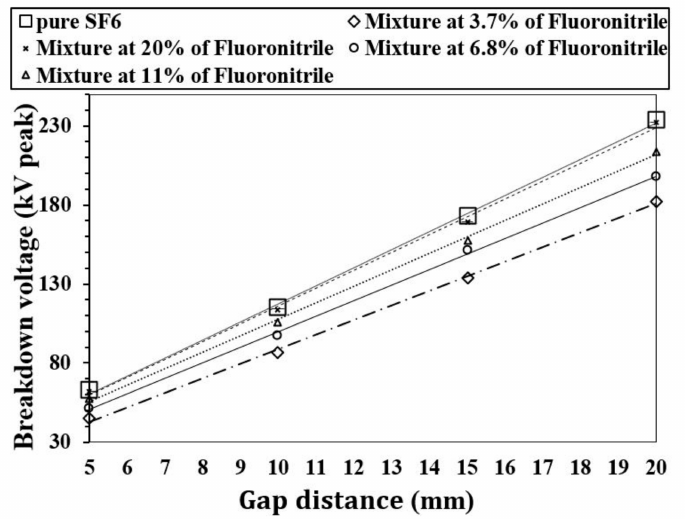
Figure 12. AC breakdown voltage of fluoronitrile/CO 2 mixtures, SF 6 at 0.1 MPa and 20 ◦ C, in sphere-to-sphere configuration referred to plane-to-plane configuration [58].